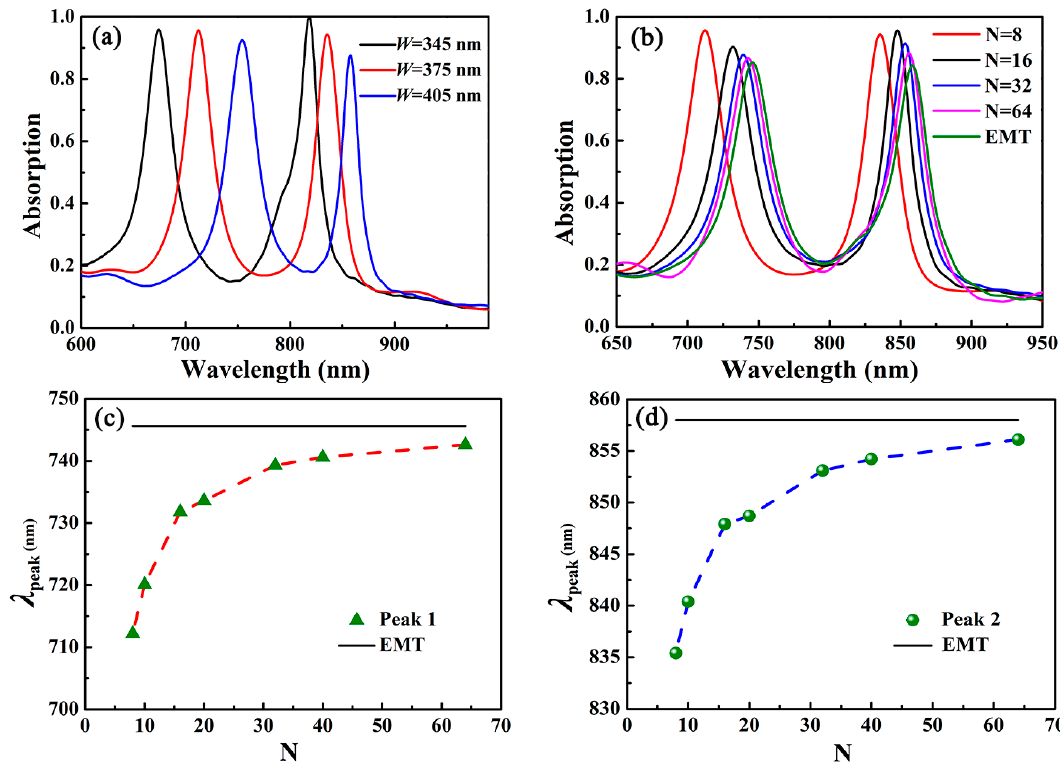
Figure 6. Influence of the width and the number of film stack on absorption response of the HRA. Other parameters are the same as those in Figure 1a. ( a ) Absorption response of the HRA as a function of W . ( b ) Absorption response of the HRA as a function of N with the fixed D and f ; absorption response of the HRA calculated by using the EMT. ( c ) Location of peak 1 for different N comparing with that of the EMT. ( d ) Location of peak 2 for different N comparing with that of the EMT.